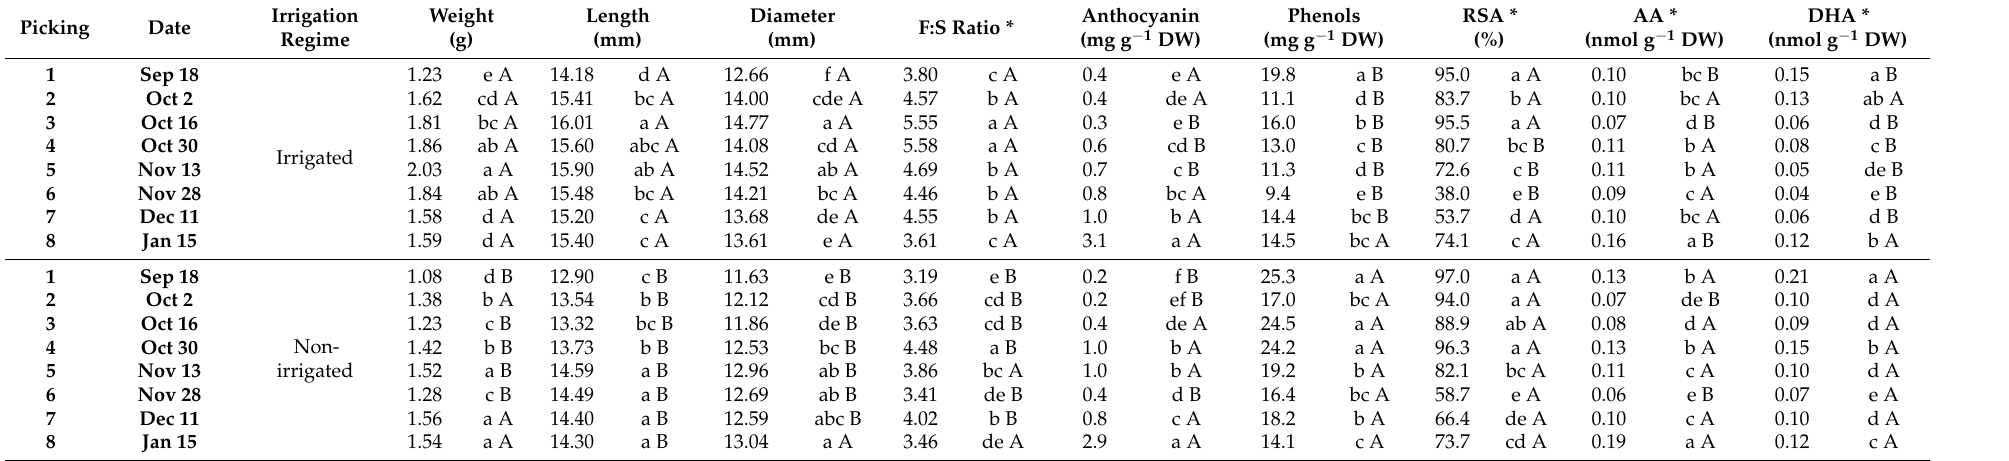
Length and diameter data represent means of 10 individual fruits. Weight and F:S ratio correspond to means of two 10-fruit replicates. For chemical properties, values represent means of three replicate analyses undertaken on lyophilised pericarp tissue. Different capital letters denote significant differences between irrigated and rain-fed samples for a given picking date, and different lower-case letters stand for significant differences among sampling dates for a given irrigation regime, at p ≤ 0.05 (LSD test). * Abbreviations: F:S ratio, flesh-to-stone ratio; RSA, radical-scavenging capacity; AA, reduced acid ascorbic; DHA, dehydroascorbic